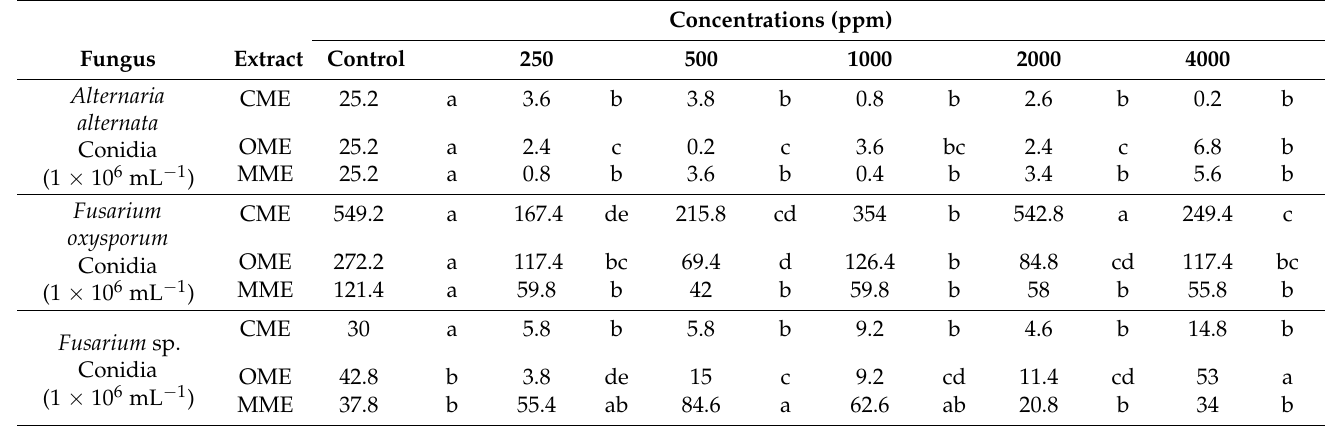
Table 4. Effect of the plant extracts of mistletoe growth on different hosts on the number of coni- dia/mL produced by Alternaria alternata , Fusarium oxysporum , and Fusarium sp. Concentrations